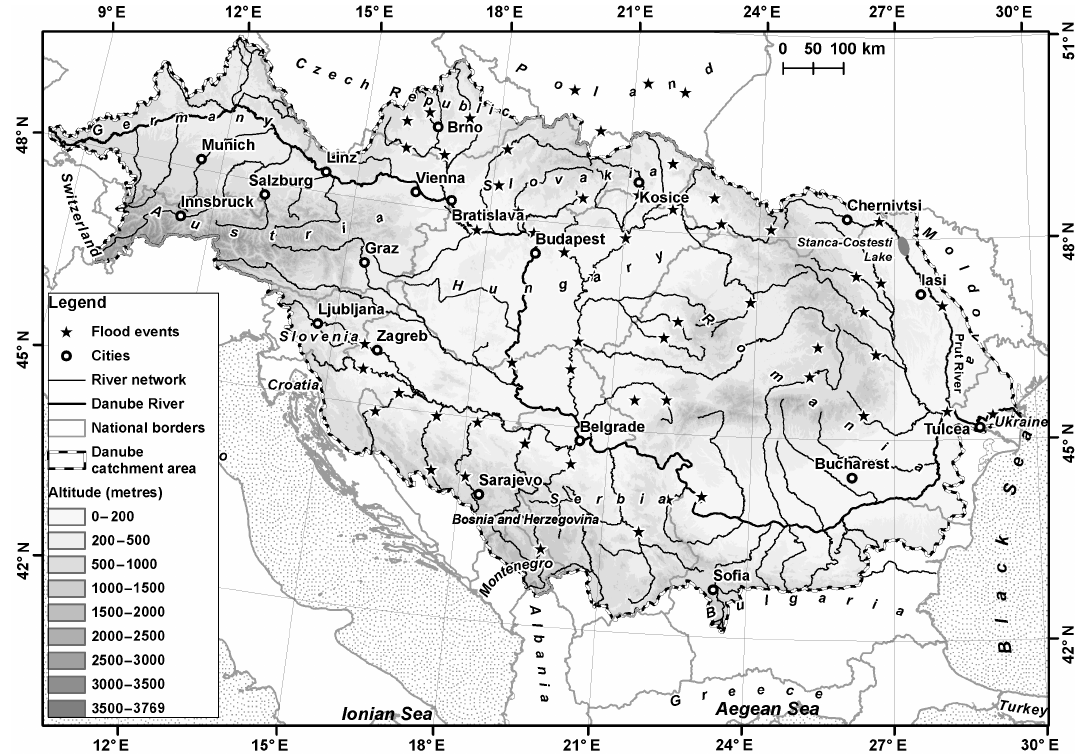
Figure 1. The Danube catchment and the location of the most important floods that occurred from May to June